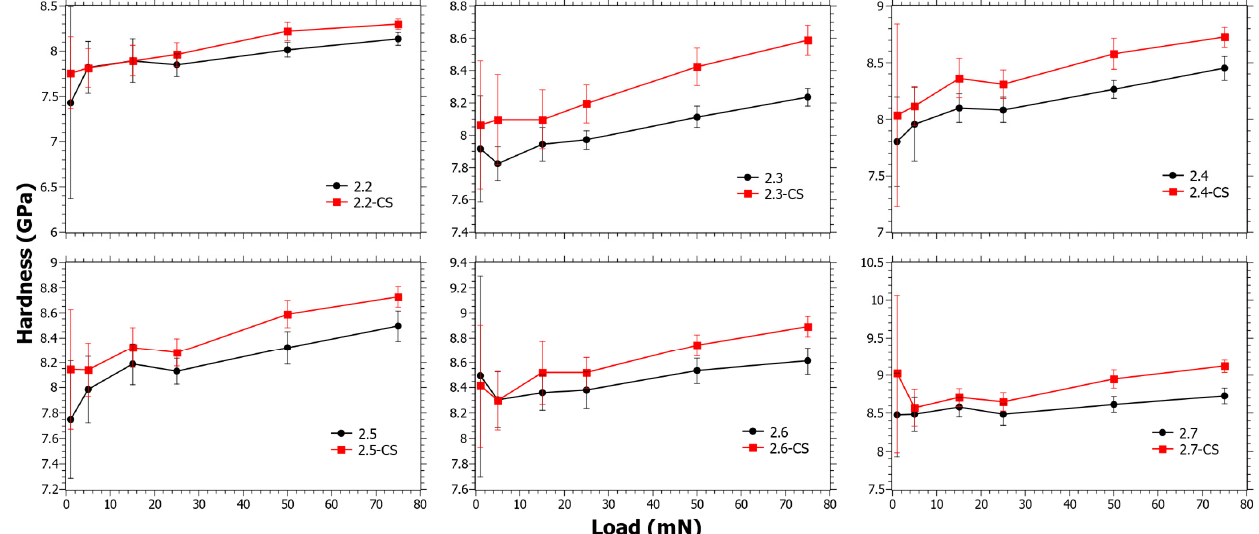
Figure 3. Nano-indentation hardness as a function load for Series 2 before and after chemical strengthening (CS).